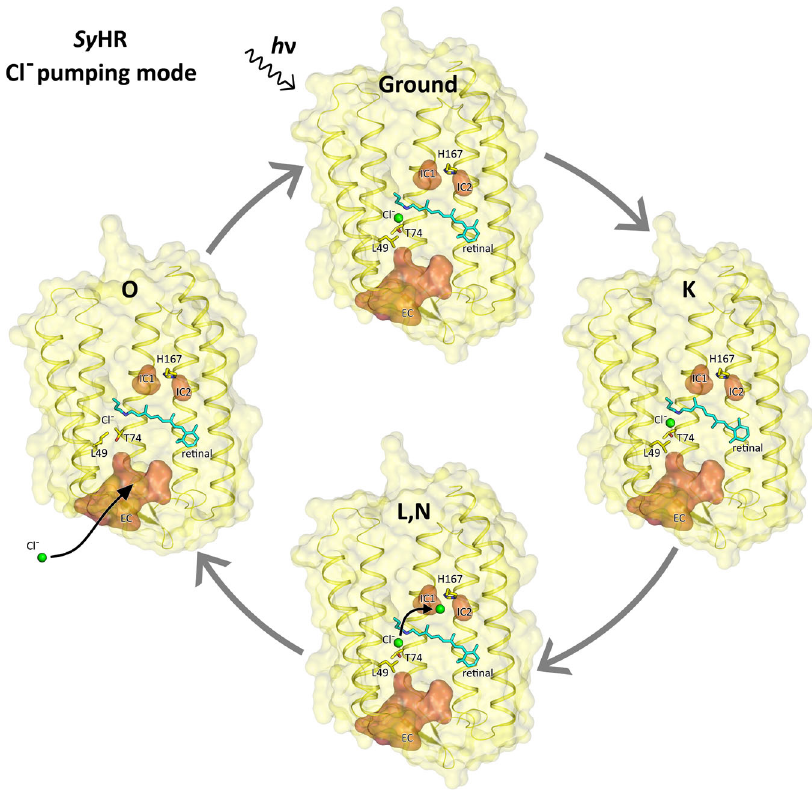
Fig.5|Schematicrepresentationofthechloridepumpingmechanismby Sy HR during photocycle. Models of the ground, K, and O states were obtained in the present work. The model of the L,N state is lacking and is shown schematically basedonthestructureofthegroundstateofCl − -boundformof Sy HR.Thesideview